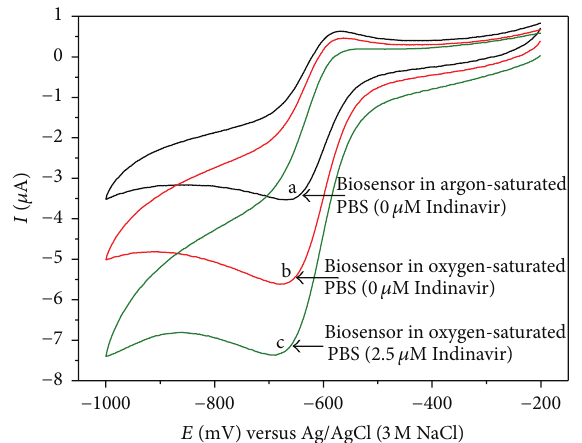
Figure 6: Biosensor in argon-saturated PBS (0 𝜇 M Indinavir) (a); oxygen-saturated PBS (0 𝜇 M Indinavir) (b); and oxygen-saturated PBS containing 2.5 𝜇 M Indinavir (c).